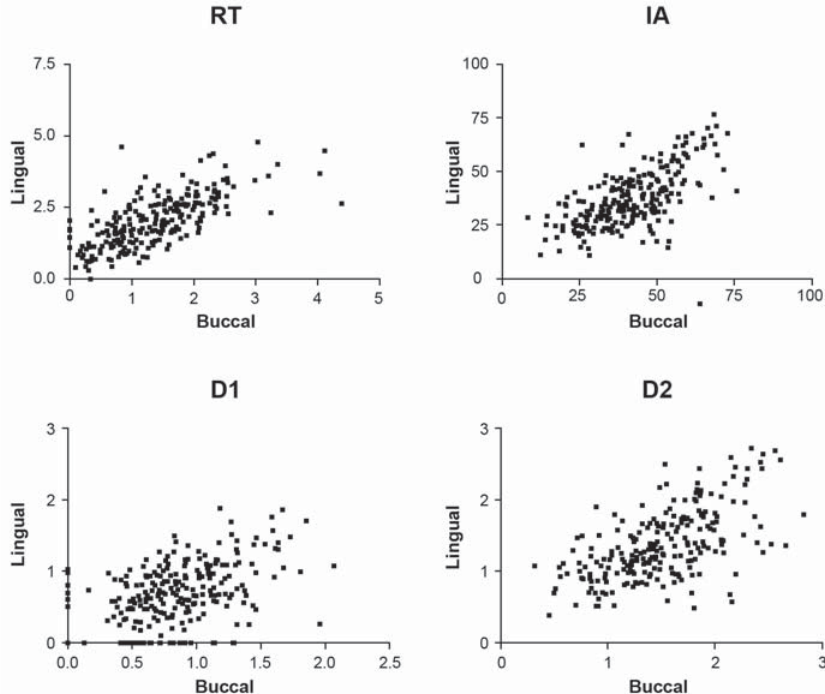
Figure 4- Pearson’s correlation analysis between buccal and lingual surfaces for root trunk height (RT) (a), D1 (b), D2 (c)